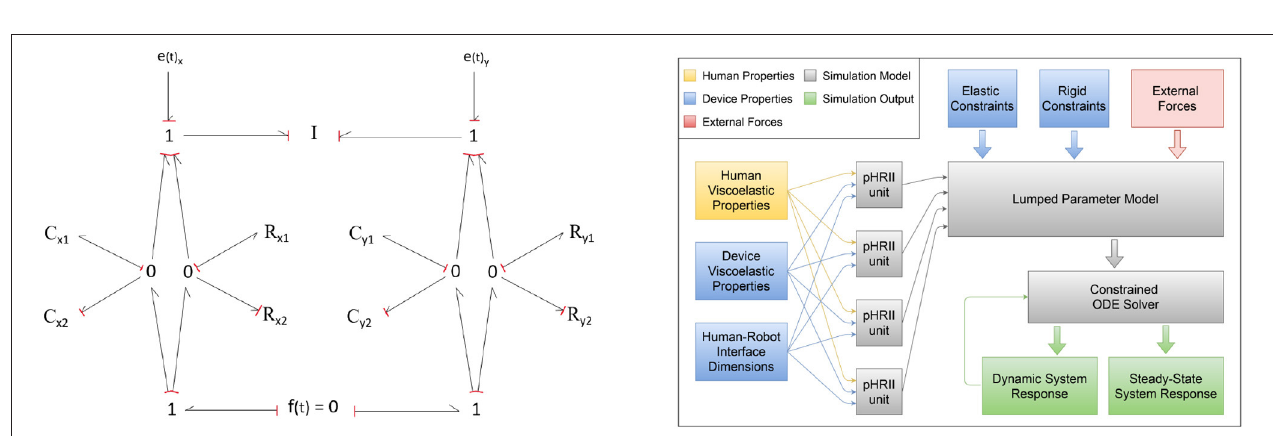
FIGURE 3 | (Left) A cross section view of a typical PHRII showing the human reference structure as the ground (the proximal phalanx of the index finger in this case) and the rigid reference structures of the robot above and below it. The numbered circles represent the PHRII units that this structure will be simplified to later in the analysis. (Right) A typical PHRII with a schematic representation of the viscoelastic elements. Each simulated point is considered as two elements coupled in series, representing the human soft tissue and the device’s compliant padding, respectively.